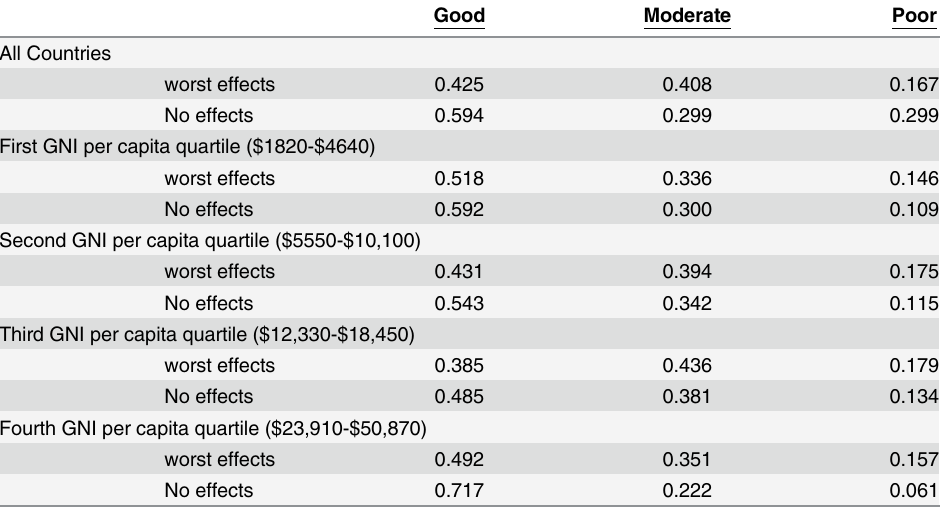
Table 10. Predicted probabilities of Self-Rated health by recession